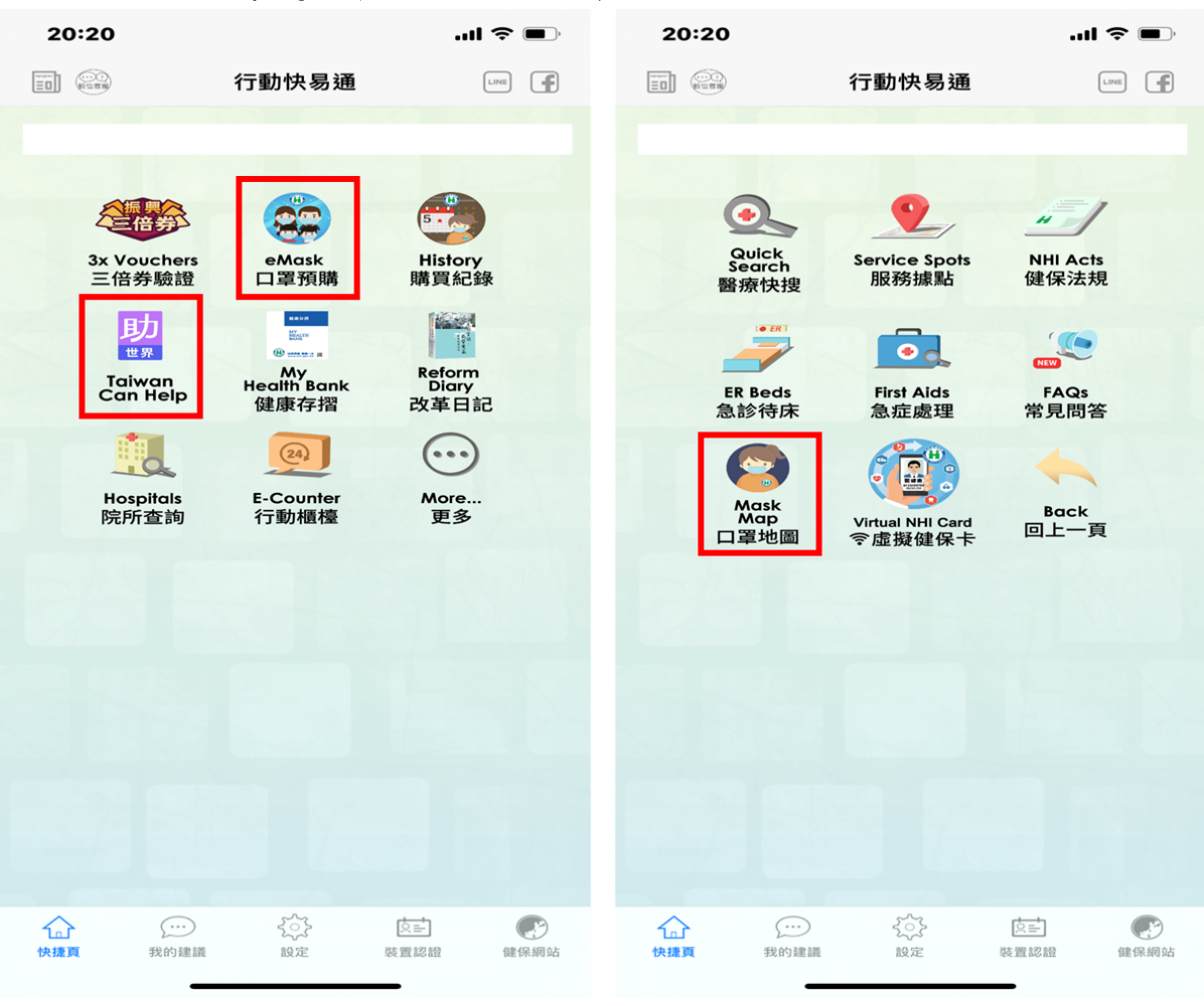
Figure 4. Preordering masks (screenshot from My Health Bank mobile app): Users can log in with their ID or mobile phone number to buy masks, check the stock of masks in nearby drugstores, or even donate their mask quotas to other